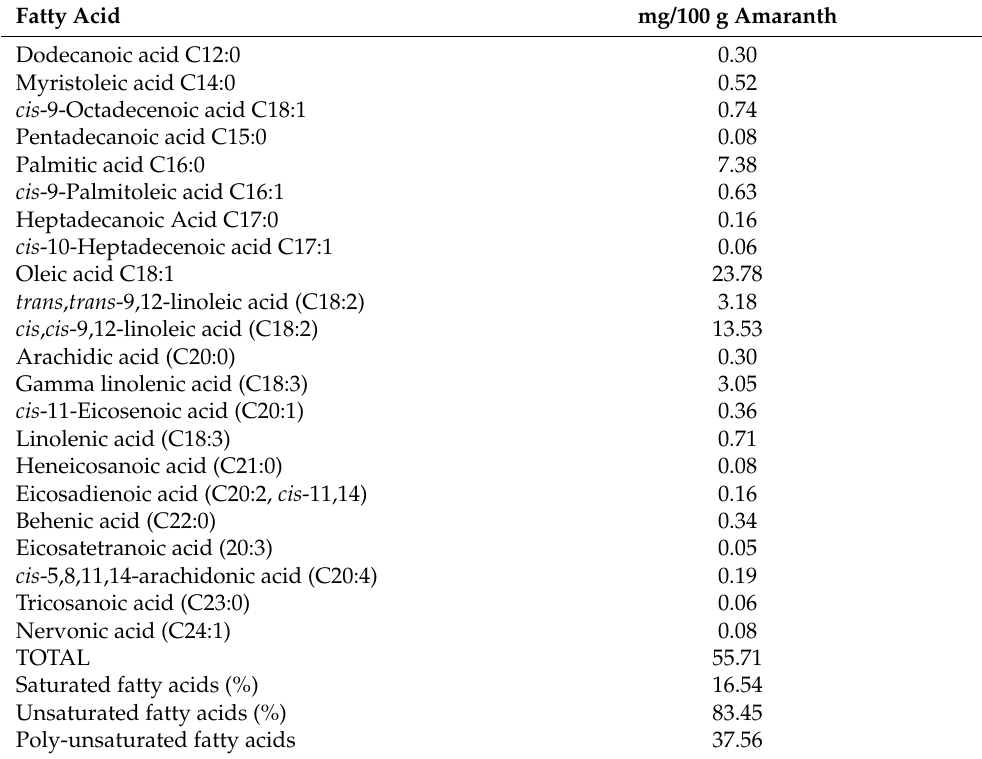
Table 4. Fatty acid composition of amaranth